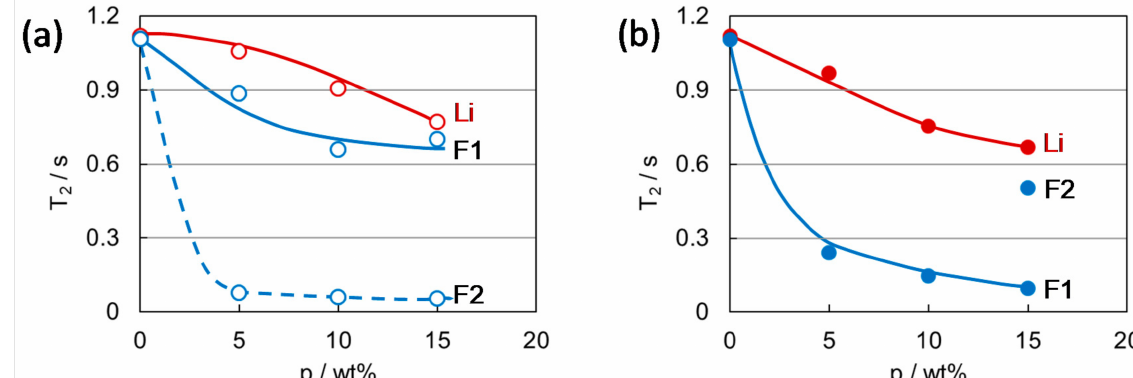
Figure 13. T 2 (Li) (red symbol) and T 2 (F) (blue symbol) change with the polyvinylidene difluoride (PVDF) polymer fraction of the gel for ( a ) annealed and ( b ) quenched gels. T 2 (F) of the annealed and quenched gels at 15 wt% of PVDF were estimated by two-component fitting: T 2 (F1) is the major component (>80%), while T 2 (F2) is the minor component (<20%). The electrolyte solution used for gelation is 1 M LiTFSI/PC, in which LiTFSI was selected to reduce the deterioration of the electrolyte by gelation and mono-solvent. PC was selected to simplify the gel structure. Reprinted with permission from [42]. Copyright 2019 ACS